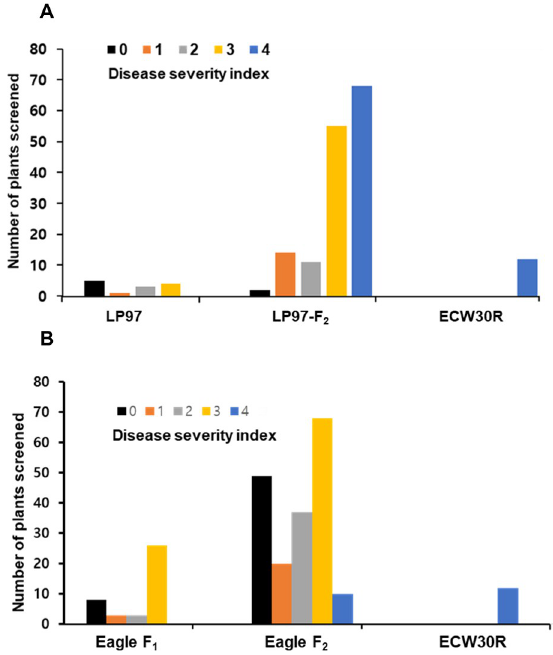
Fig 1. Frequency distribution of disease severity. Evaluation of resistance of the LP97-F 2 population and control plants (A) and of Eagle-F 1 and Eagle-F 2 plants (B) to Pepper yellow leaf curl virus (PepYLCV) Indonesia strain performed 6 weeks after transfer of seedlings to the screen house. The disease severity index from 0 to 4 was used.